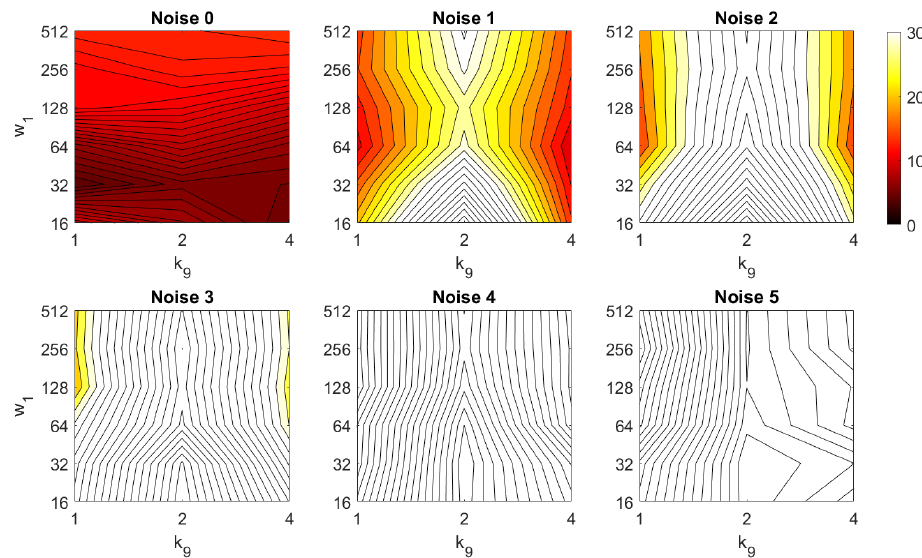
Figure 38. WS orientation estimation in the presence of noise. Average orientation error